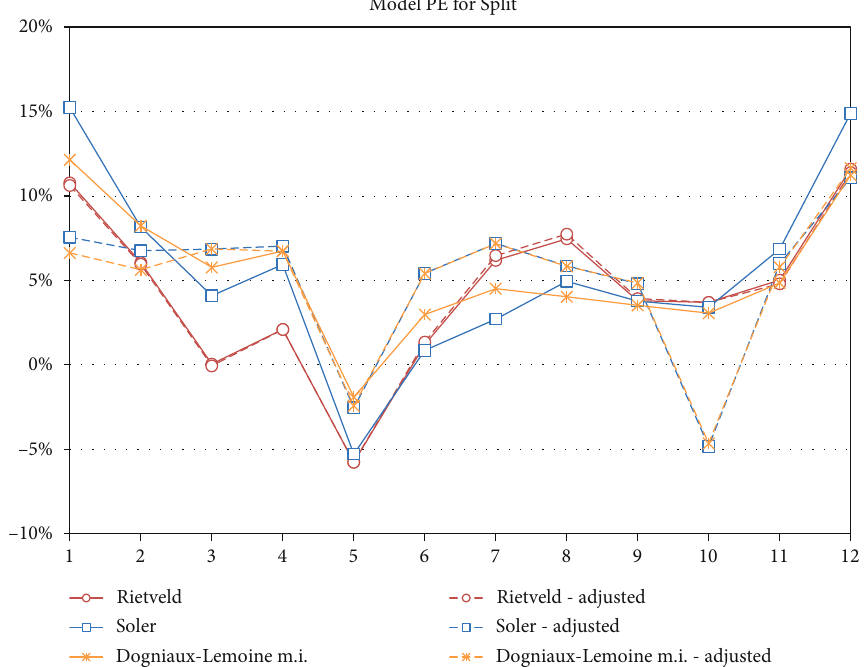
Figure 5: Comparison of percentage error of original and adjusted models for Split.